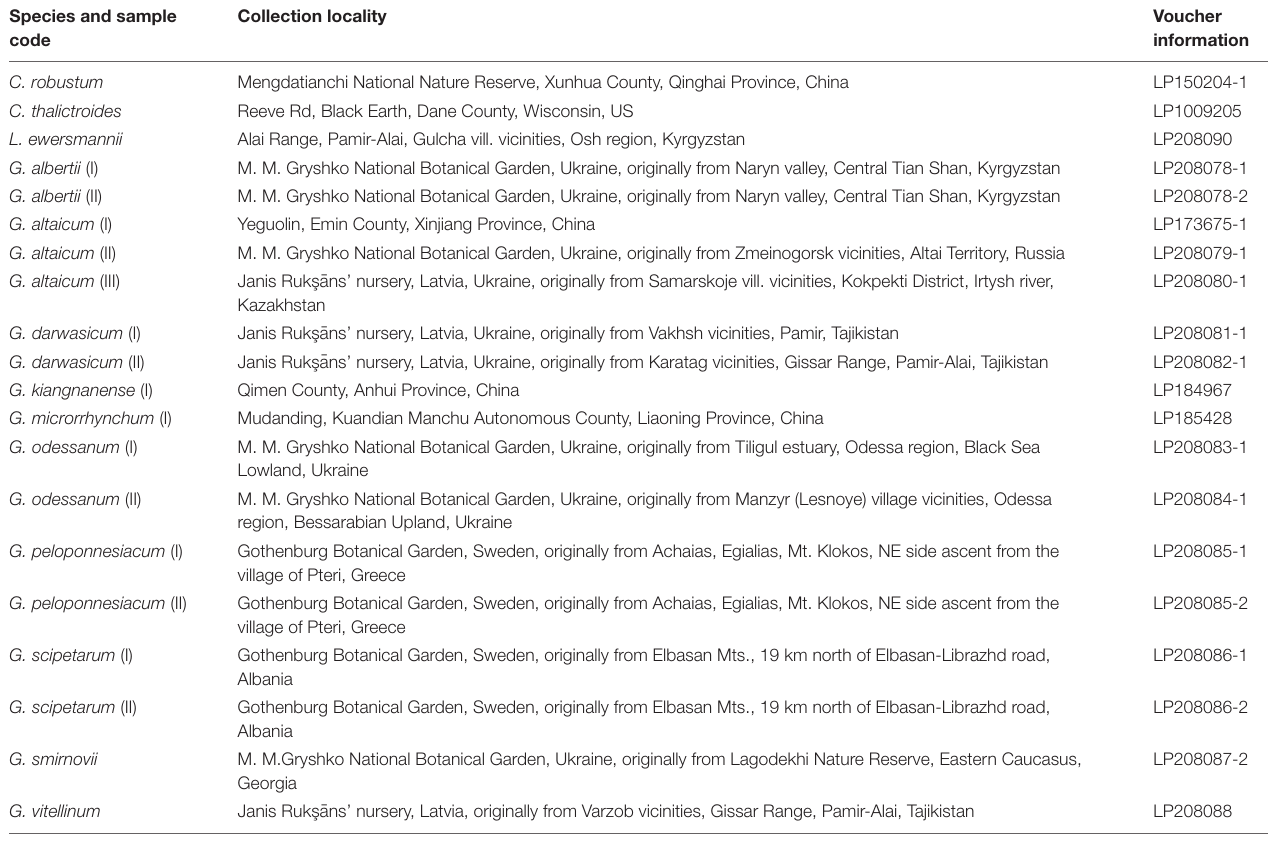
TABLE 1 | Collection locality and voucher information of the Nandinoideae species and accessions used in the present